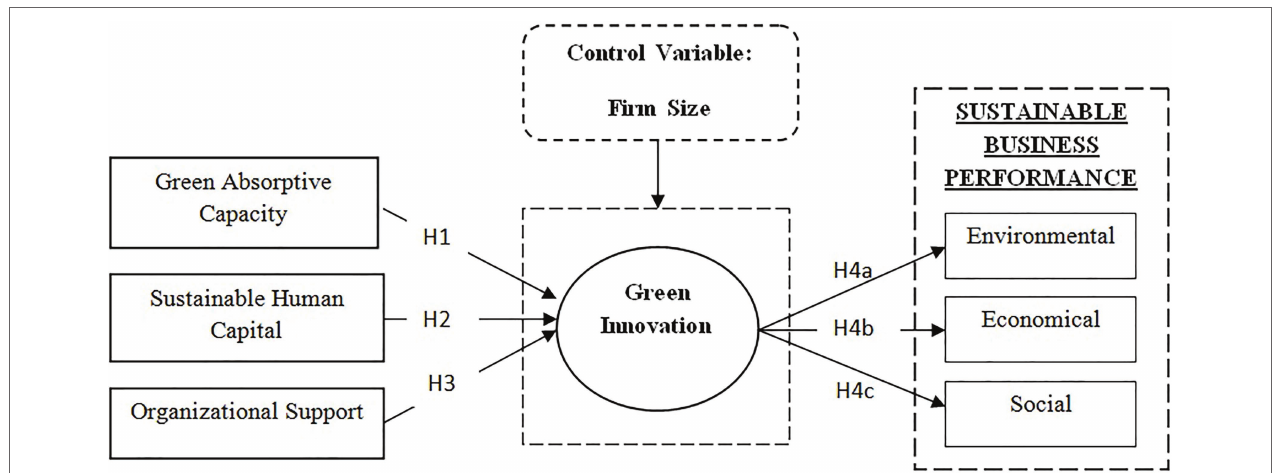
FIGURE 1 | Research model.